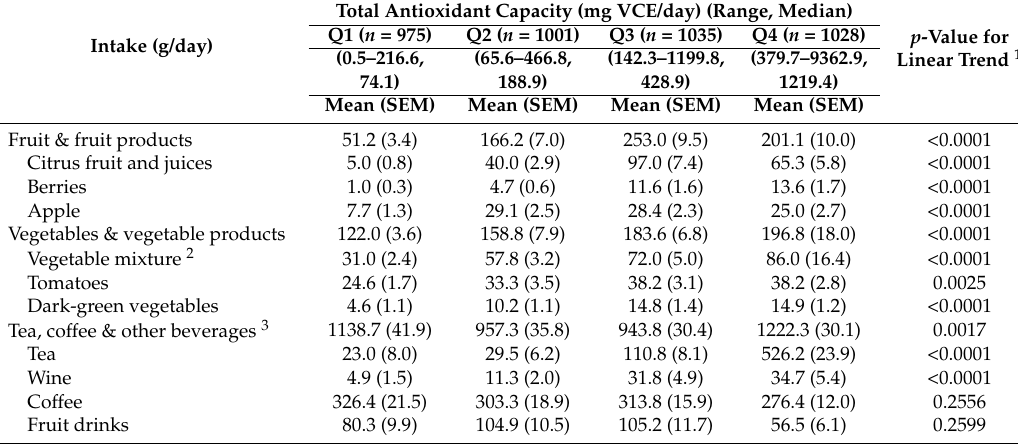
Table 4. Major food intakes by energy-adjusted quartiles of total antioxidant capacity among U.S. adults in the NHANES 2007–2012 (g/day) ( n =